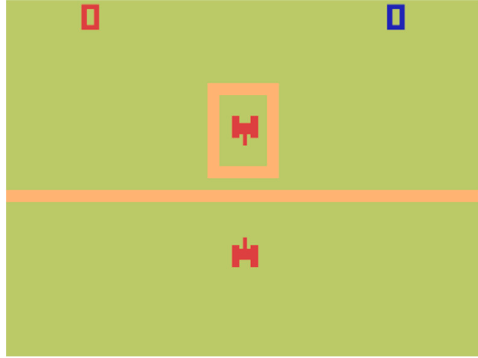
Figure 10. Travis Bickle, the tank, confronts himself in the mirror.